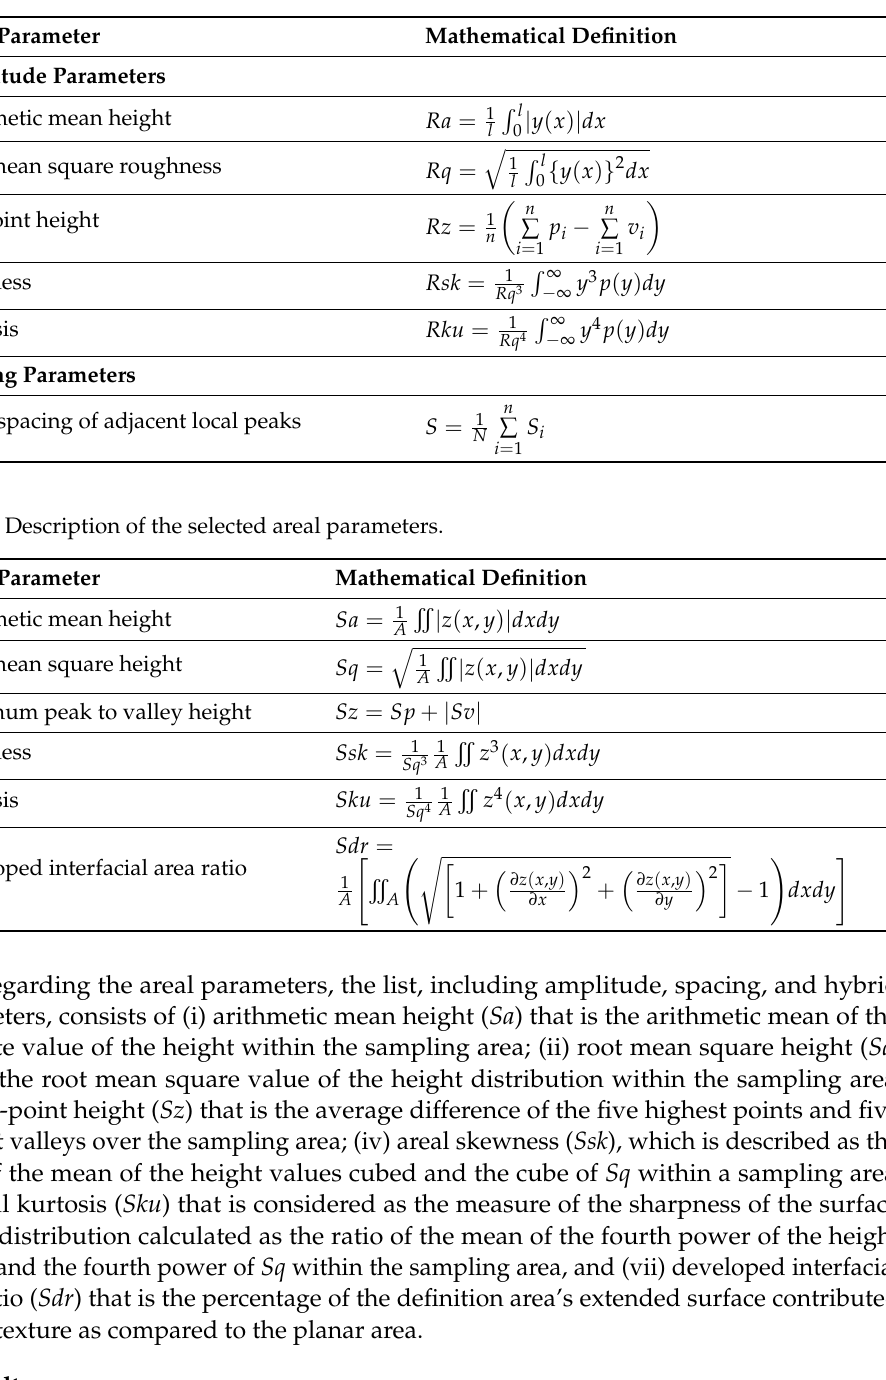
Table 2. Description of the select profile parameters.